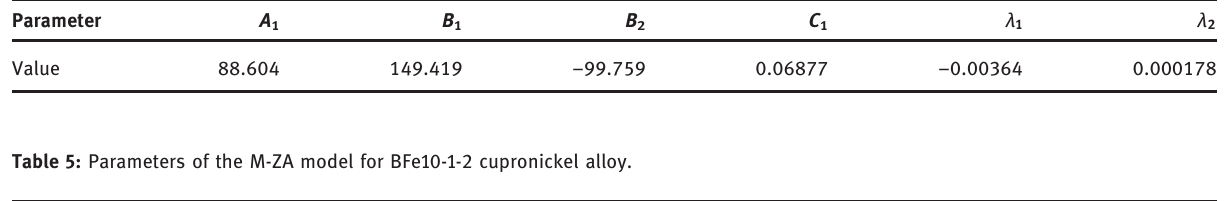
Table 5: Parameters of the M-ZA model for BFe10-1-2 cupronickel alloy. Parameter